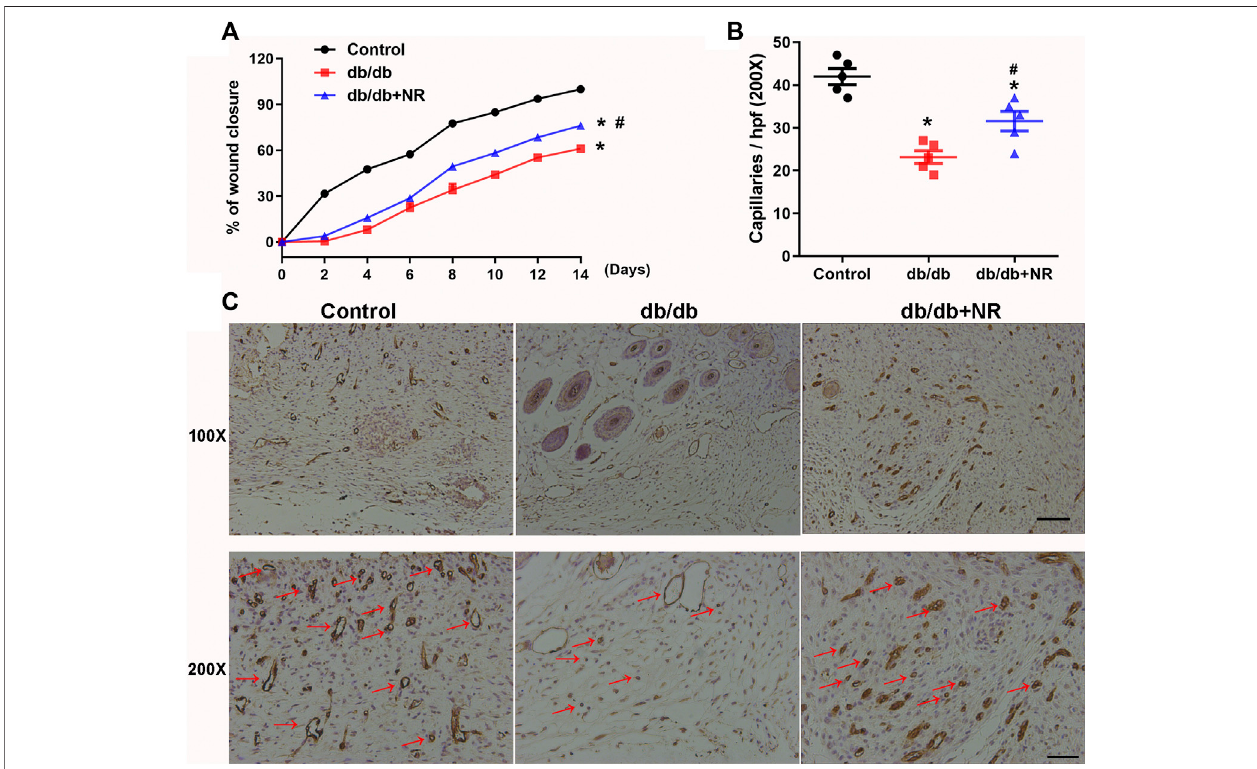
FIGURE2 | Effects ofNR supplement on wound closure and wound angiogenesis in db/db mice. (A) Full-thickness skin wounds were made in common food and NR-supplied food fed db/db mice. Quantitative analysis of wound closure at indicated time intervals (B) . Immunohistochemical analyses of CD31 in day-14 wounds of mice and quantitative study (C) . Red arrows point out CD31-positive capillaries (100 × , scale bar, 100 μ m; 200 × , scale bar, 50 μ m). Values are mean ± SEM ( n (cid:2) 5). * P < 0.05 vs. control; # P < 0.05 vs. db/db